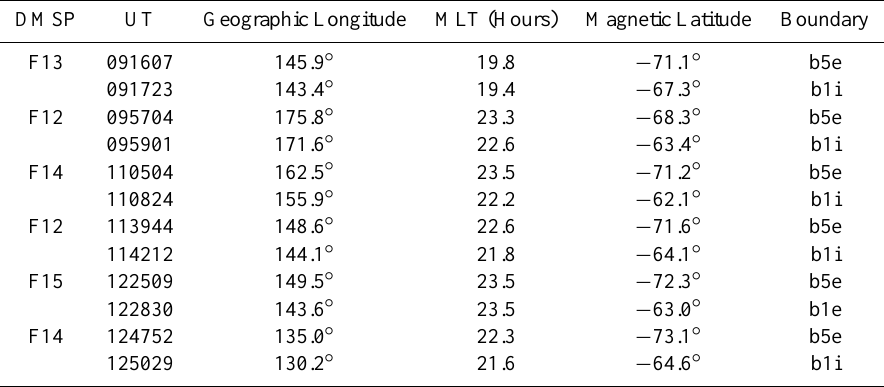
Table 1. Nightside auroral oval boundaries superimposed in Figs. 3 and 4 DMSP UT Geographic Longitude MLT (Hours) Magnetic Latitude